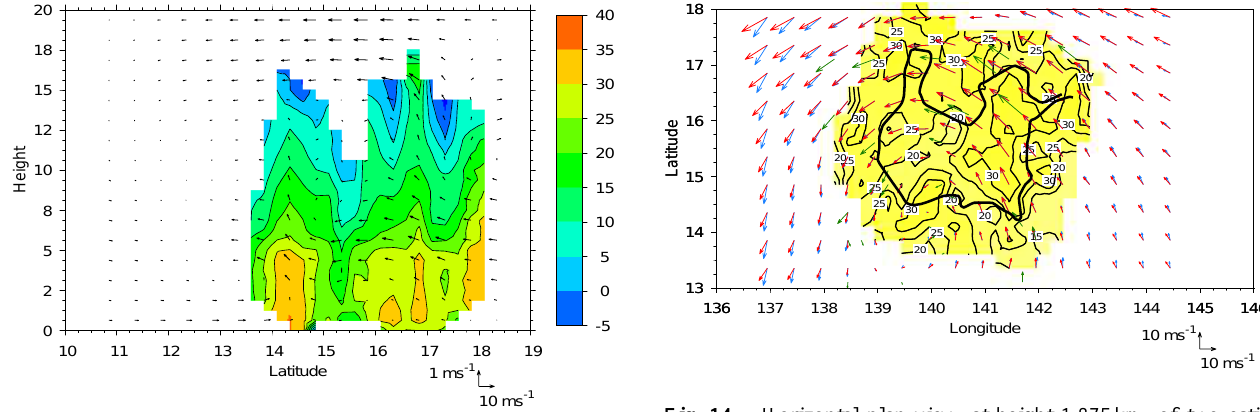
Fig. 14. Horizontal plan view, at height 1.875km, of two esti- mates of the wind field along with winds measured by dropsondes. All velocities are Earth-relative. Dropsonde winds are shown in green; the wind retrieved, using radar data only, is in blue; the wind retrieved, using radar plus dropsondes, is shown in red. The scale of the meridional and zonal winds is shown at the bottom of the plot. Areas where reflectivity exist are shown in yellow. Contours of the reflectivity are also shown every 5 dbz. The thick black line represents the aircraft